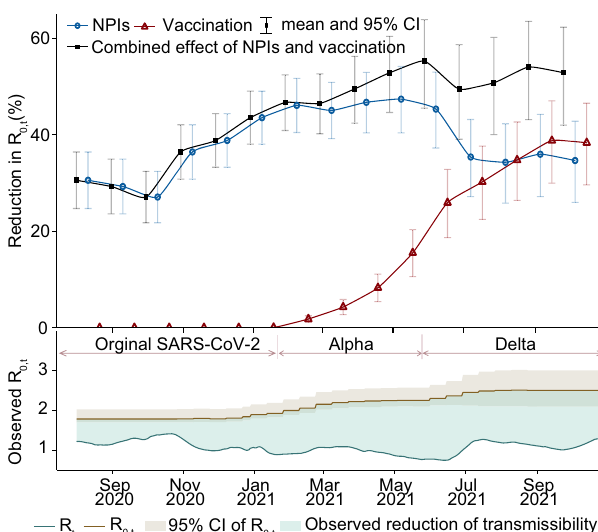
Fig. 2 The effects of NPIs and vaccination on reducing COVID-19 transmission in Europe over time. The overall monthly effects of interventions on reducing R 0, t across 31 countries from 1 August 2020 to 25 October 2021 are presented with mean and 95% CI, which was pooled from national level to regional level using meta-analysis. The total effect of NPIs presented here is the effect of NPIs alone plus their interaction effect with vaccination, and the total effect of vaccination shown is the impact of vaccination alone plus its interaction effect with NPIs. In the bottom panel, the light blue area between R 0, t (instantaneous basic reproduction number) and R t (instantaneous reproduction number [solid line]) illustrates the observed reduction of COVID-19 transmissibility. R 0, t are presented with mean (dash line) and 95% CI (grey area). Periods in which Alpha and Delta variants were dominant (>50%) are also shown by pink lines and relevant